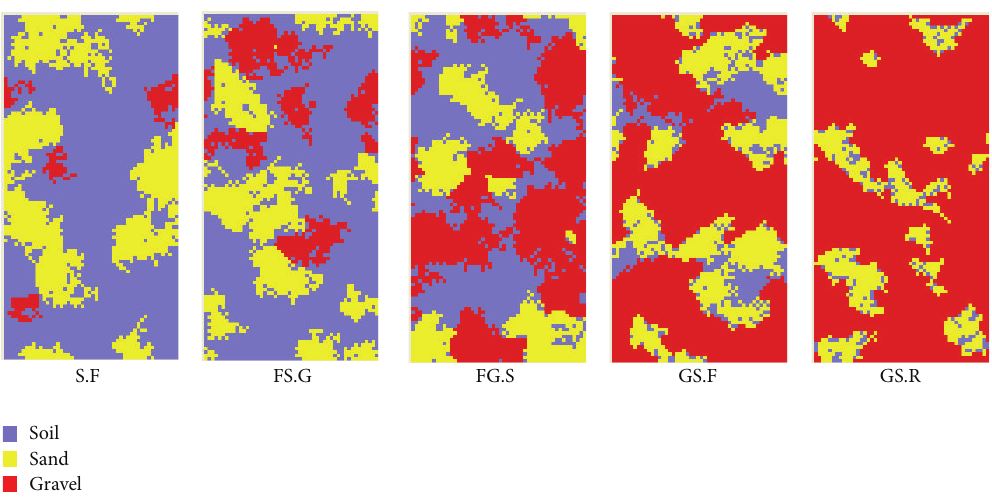
Figure 4: HHC-Granular model generated granular media samples. Table 1: Material parameters for numerical simulation tests of granular media.